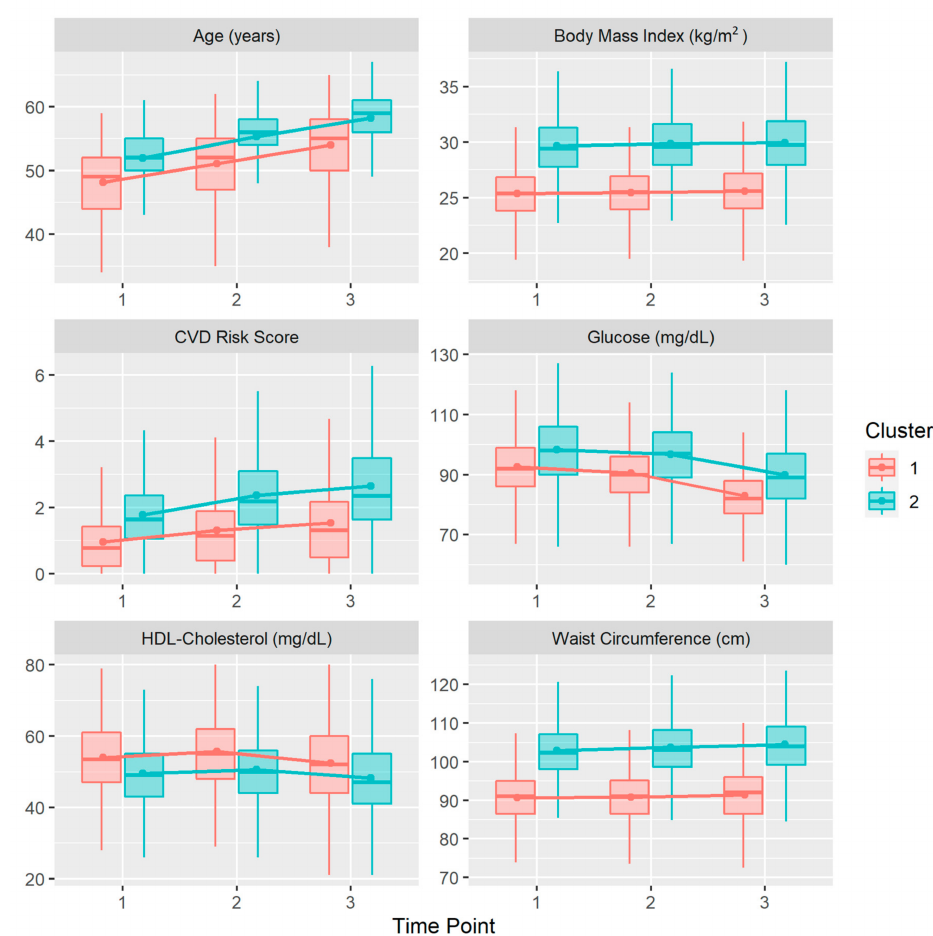
Figure 3. Box plots depicting mean values (dots) for each variable per cluster. Lines represent the evolution of the mean for each cluster over the three time points analyzed. Abbreviation: CVD, cardiovascular